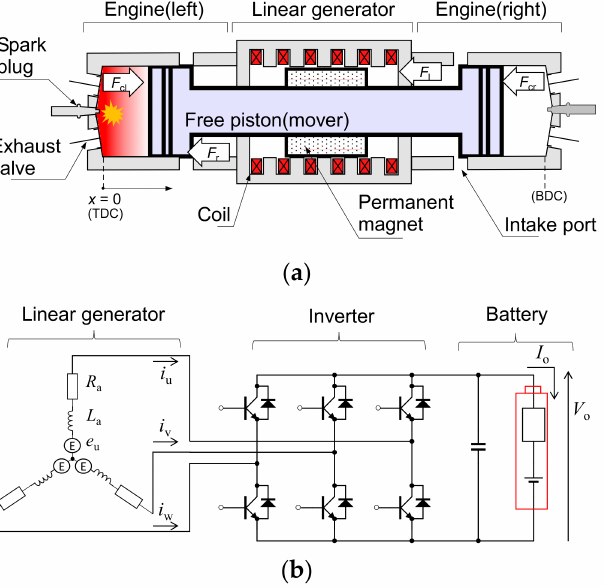
Figure 1. Basic structure of the dual-engine-type FPEG: ( a ) motion model, ( b ) circuit model.